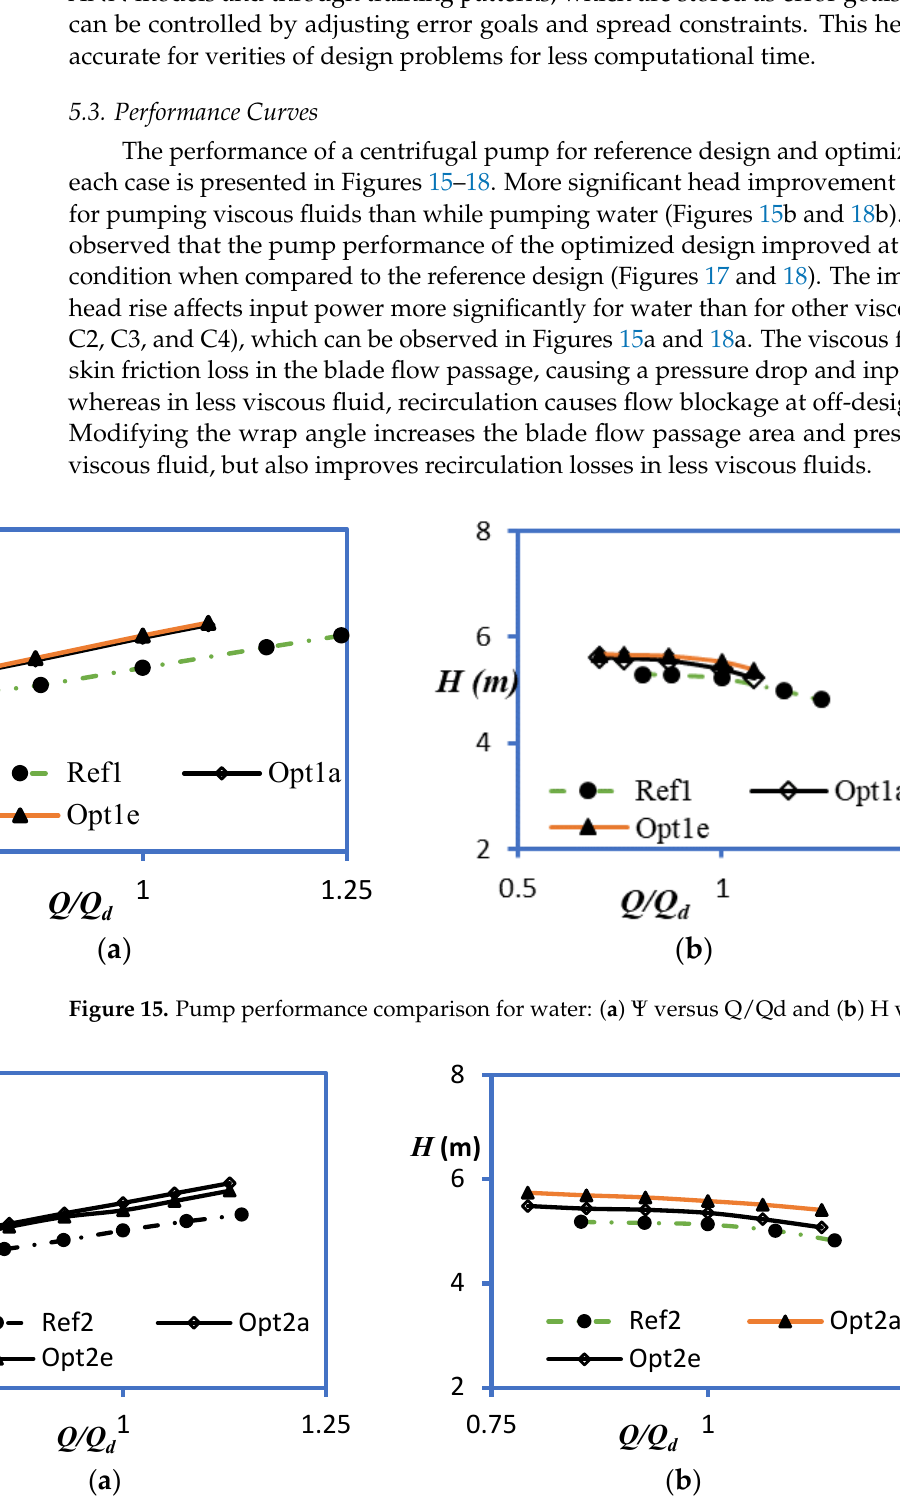
Figure 16. Pump performance comparison for oil C1: ( a ) Ψ versus Q/Qd and ( b ) H versus Q/Qd.